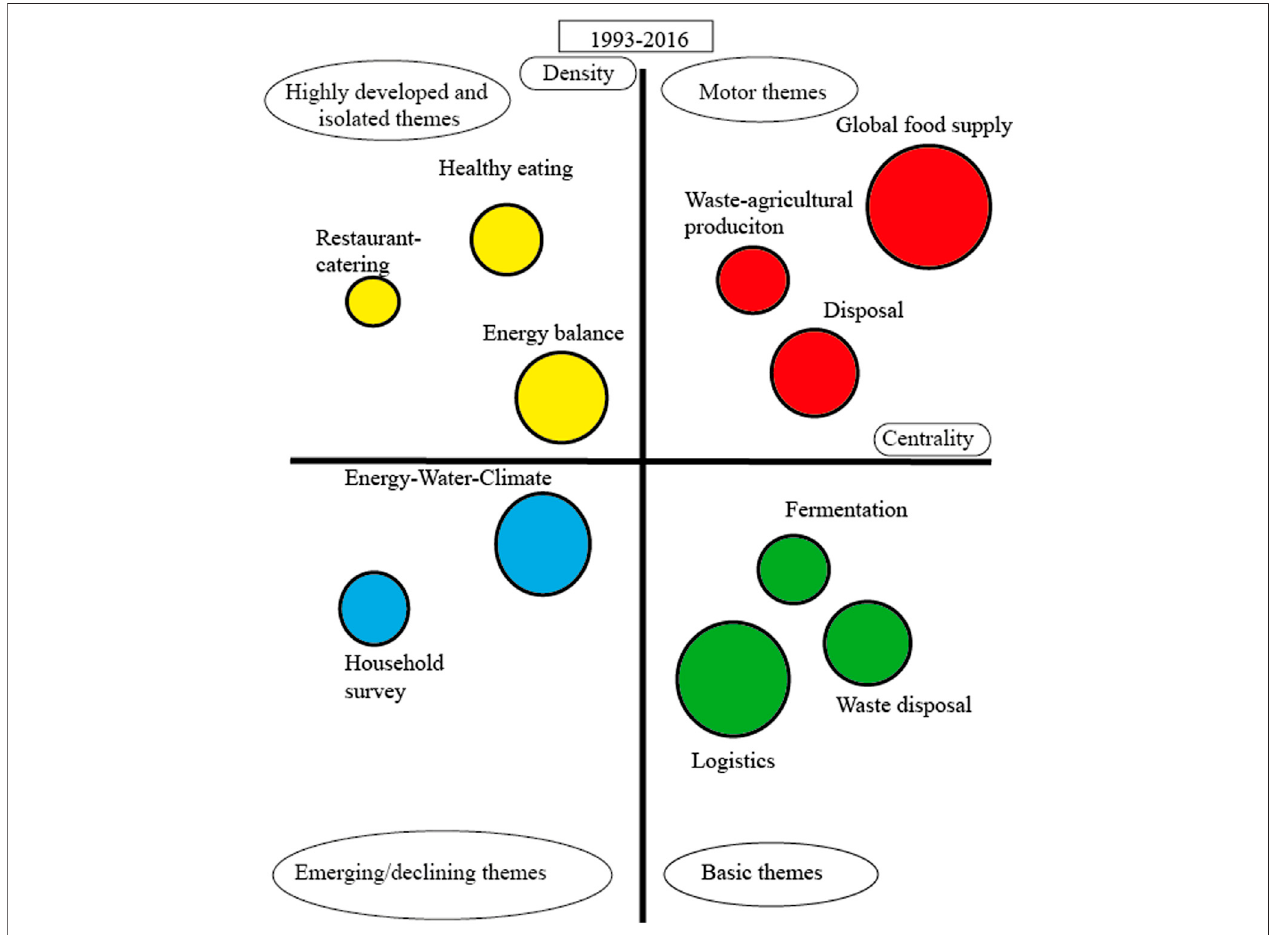
FIGURE 6 | Relative position of different themes of the household food waste problem between 1993 and 2016.